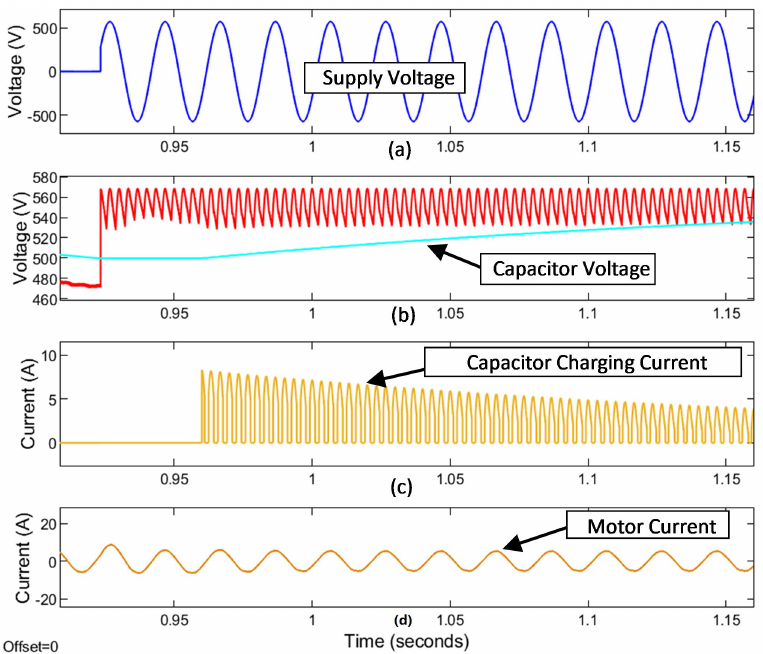
Figure 9. Simulation results for dc-link charging of capacitor Ca, ( a ) supply voltage, dc-link and ( b ) capacitor voltage, ( c ) capacitor charging current and ( d ) motor input